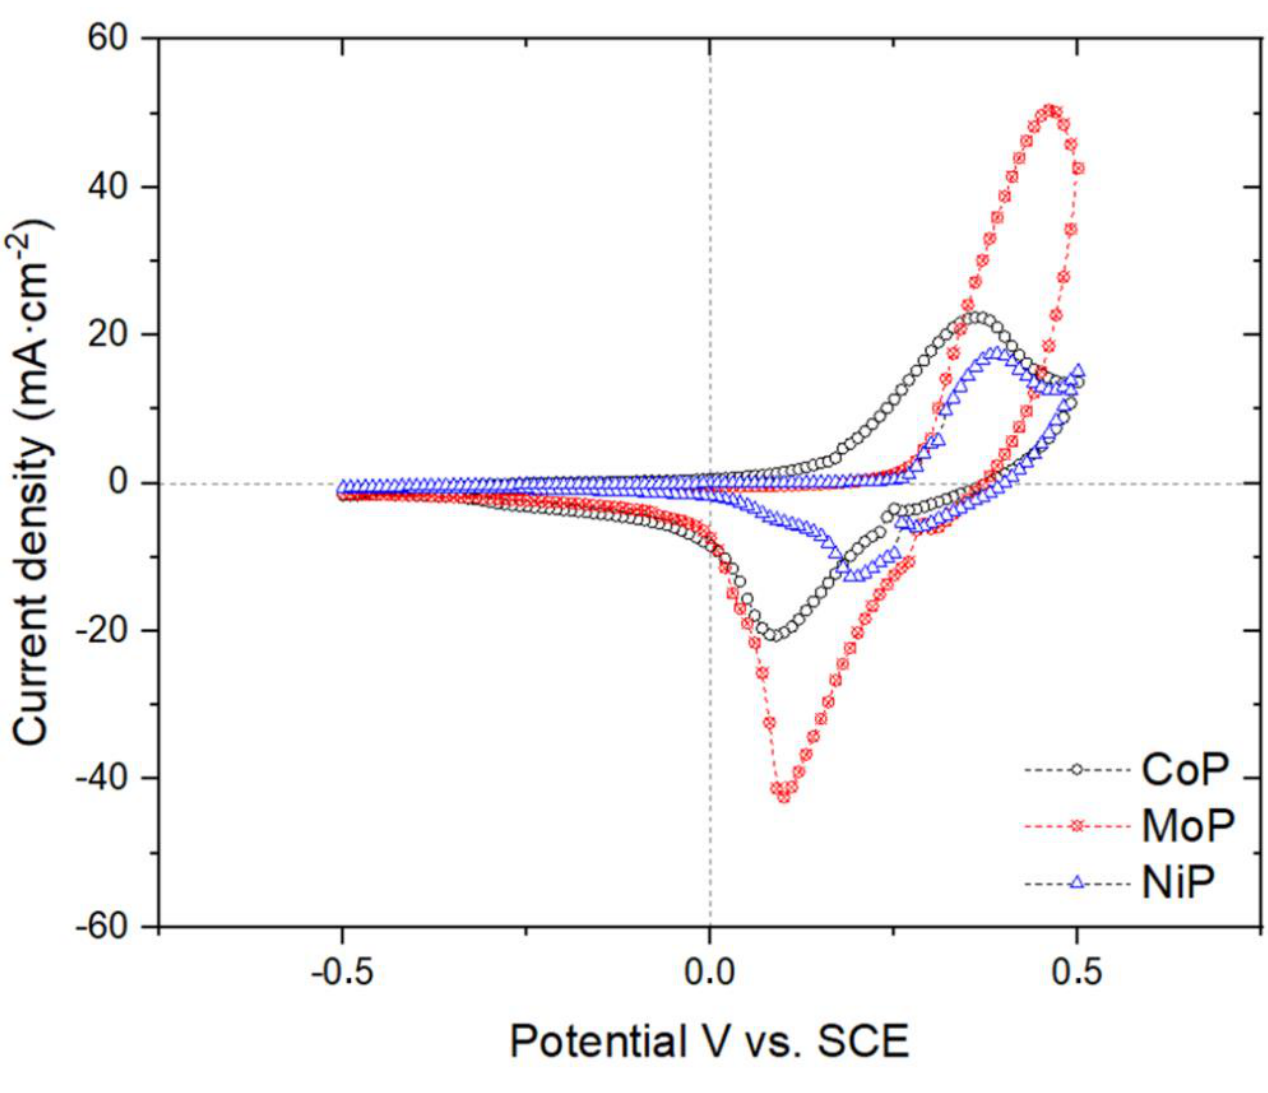
Figure 5. LSV representation for CoP, MoP, and NiP. ( a ) HER representation, ( b ) Tafel slope, and ( c ) OER plot.